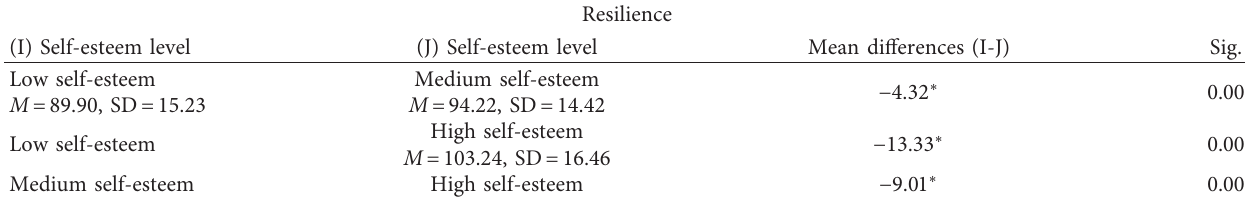
Table 5: Descriptive and post hoc tests (MSD) of differences in resilience according to self-esteem